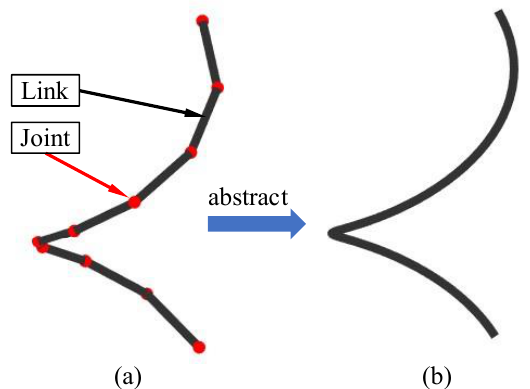
Figure 1. The abstractgou process from gait motion configuration of snake robot to backbone curve. ( a ) Snake robot configuration. ( b ) backbone curve of snake robot.